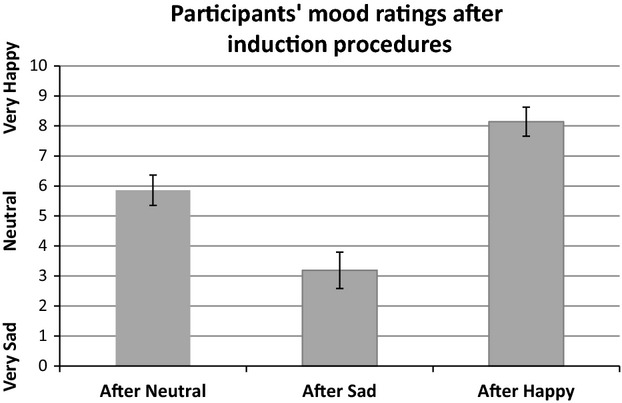
Mean mood ratings (with 95% confidence intervals) from 21 participants after watching a neutral, sad, and happy film clip in the scanner.